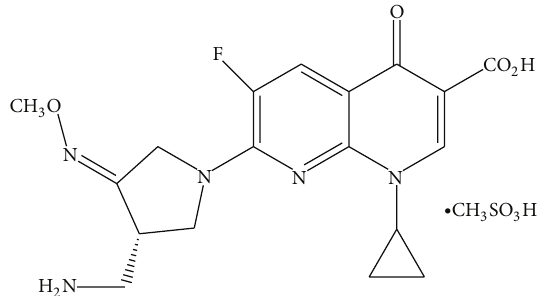
Figure 1: Chemical structure of gemifloxacin